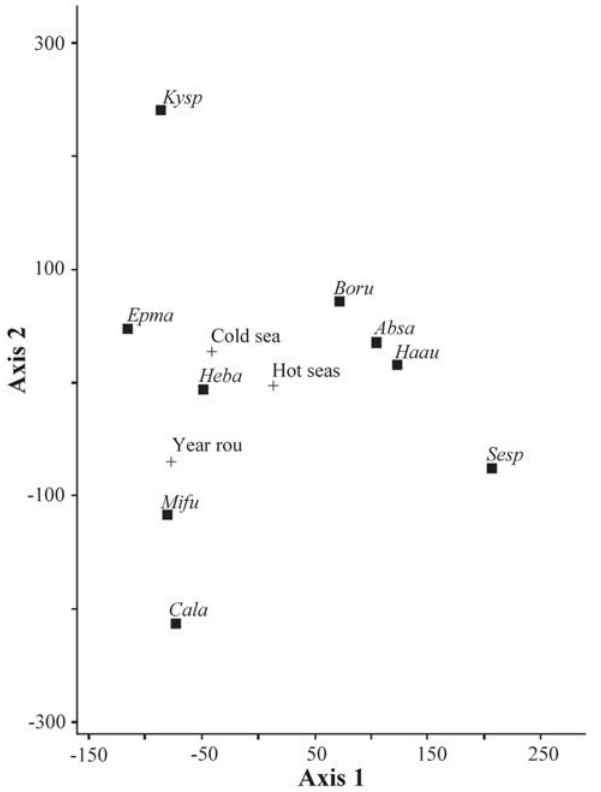
Fig. 8. Ordination plot of the correspondence analysis (first two axes) based on fishermen’s answers about reproductive (spawning) season of the nine studied fish species in the southeastern Brazilian coast: Absa = Abudefduf saxatilis ; Boru = Bodianus rufus ; Cala = Caranx latus ; Epma = Epinephelus marginatus ; Haau = Haemulon aurolineatum ; Heba = Hemiramphus balao ; Kysp = Kyphosus spp.; Mifu = Micropogonias furnieri ; Sesp = Seriola